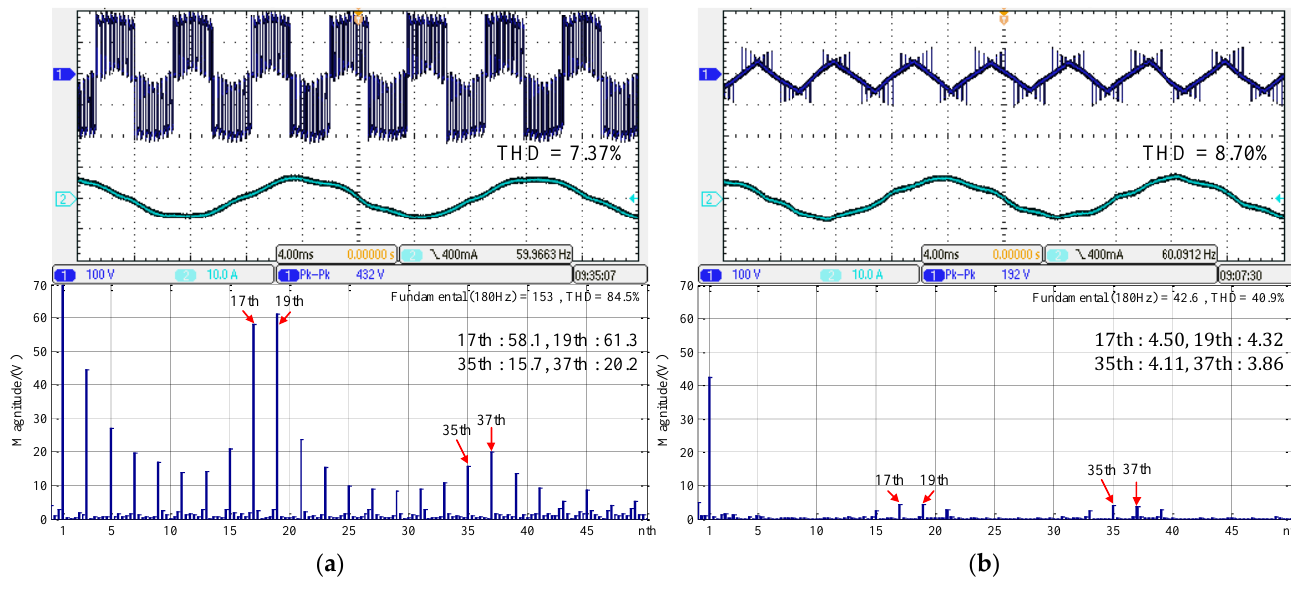
Figure 12. CMV and 𝑖 𝑔𝑎 ( 𝑚 𝑎 = 0.833): ( a ) SVM1 and ( b ) SVM2.